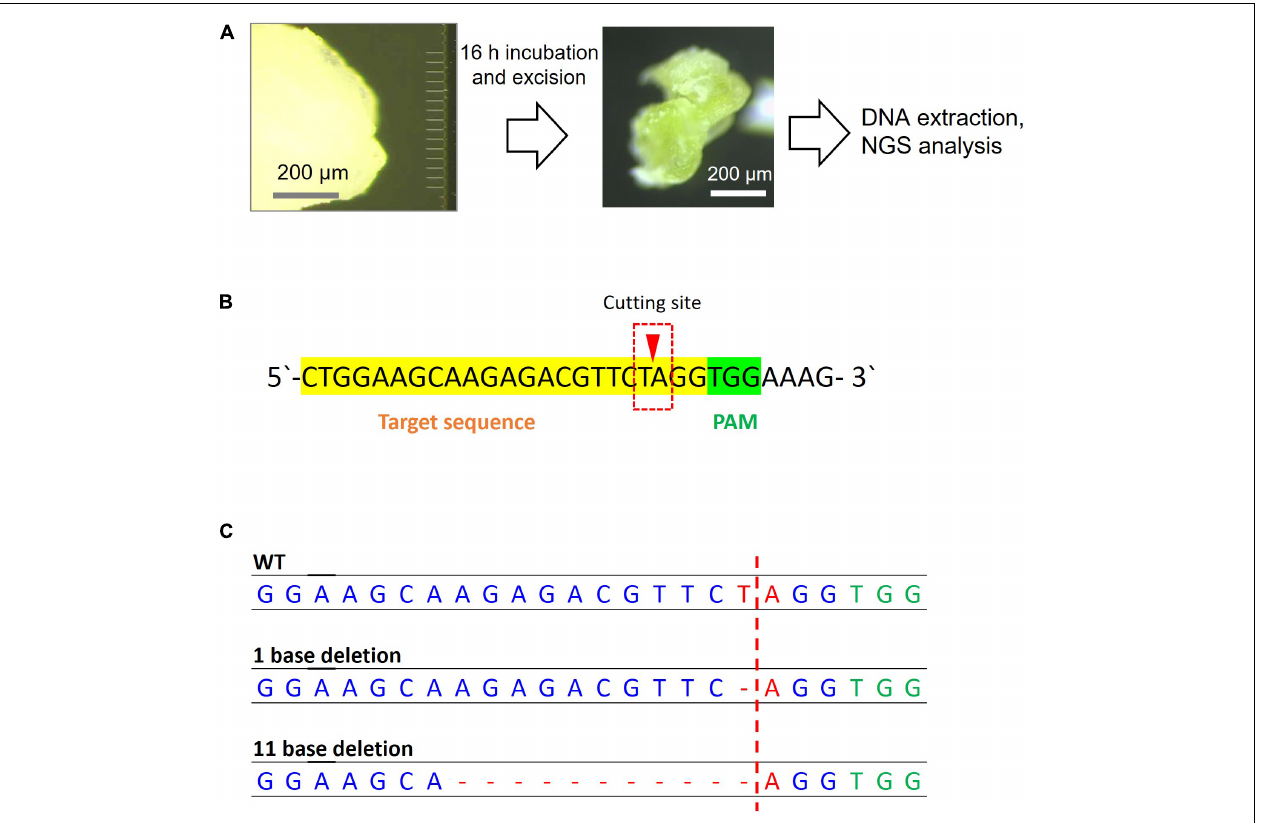
FIGURE 5 | Next-generation sequencing sample preparation and analysis results for genome editing of soybean SAM. (A) Steps of MNA insertion into soybean SAM and sample preparation for NGS. (B) The sgRNA target sequence of the PDS11 gene. The reads that have a mutation in the red box were counted. (C) The mutation patterns were found in the target sequence by NGS